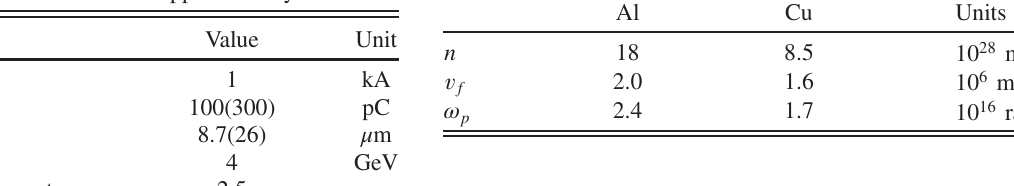
TABLE I. Selected beam and machine properties in the undulator region of LCLS-II with superconducting undulator. The longitudinal bunch distribution is approximately uniform.